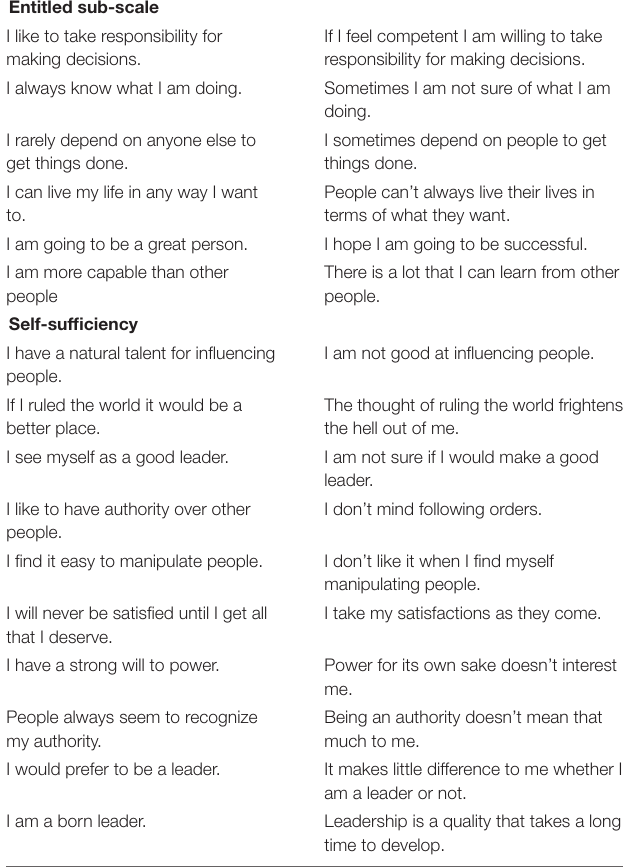
TABLE 1 | Items used for measuring entitlement and